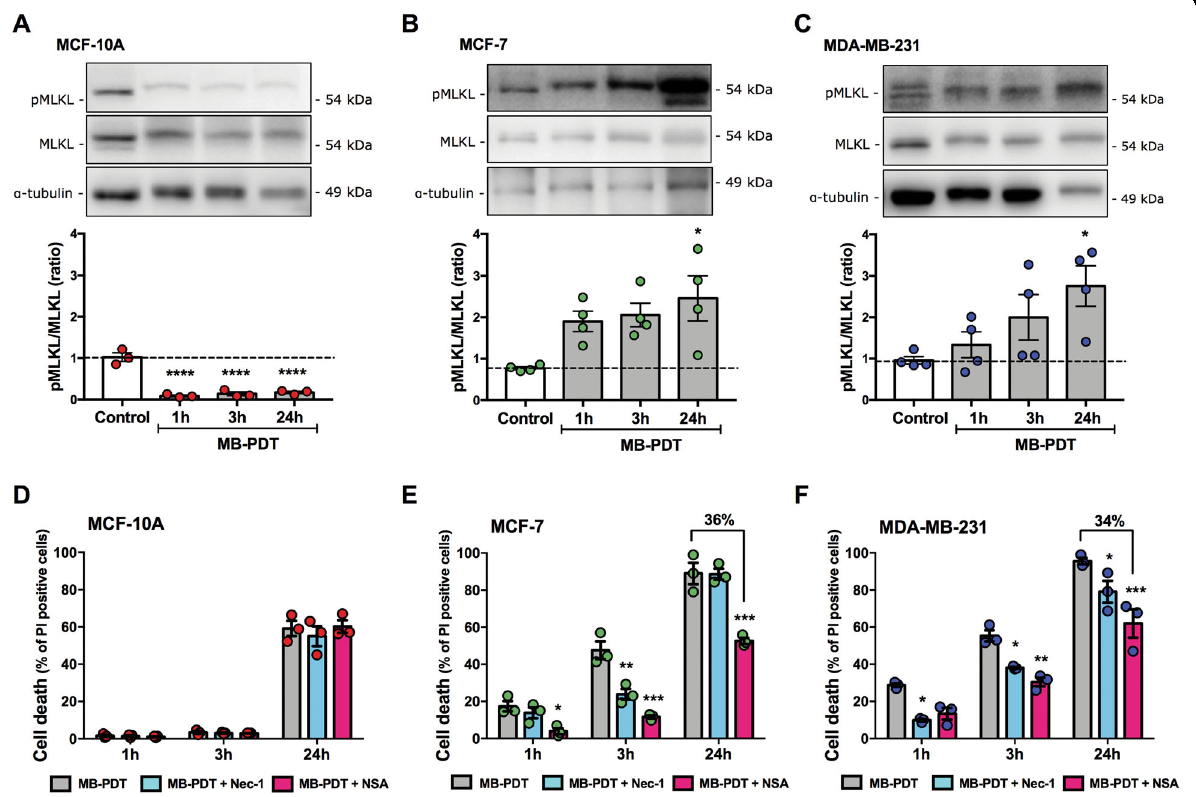
Fig. 4 MB-PDT activates necroptosis in tumorigenic breast cells. A MCF-10A, B MCF-7, and C MDA-MB-231 cells were submitted or not to MB- PDT. One, 3, and 24 h after irradiation, cells were lysed and protein extracts were submitted to western blotting. Representative images of western blottings of pMLKL, MLKL, and tubulin, and the corresponding quanti fi cation of pMLKL/MLKL ratio are shown. * p < 0.05 vs. Control ( n = 4 independent experiments). D MCF-10A, E MCF-7, and F MDA-MB-231 were pretreated or not with Nec-1 or NSA, and then submitted or not to MB- PDT. Cell death was evaluated 1, 3, or 24 h after irradiation. *** p < 0.001, ** p < 0.005, * p < 0.05 vs. MB-PDT. Dot colors representation: MCF-10A in red, MCF-7 in green, and MDA-MB-231 in blue. Results are presented as mean ± SEM ( n = 3 independent